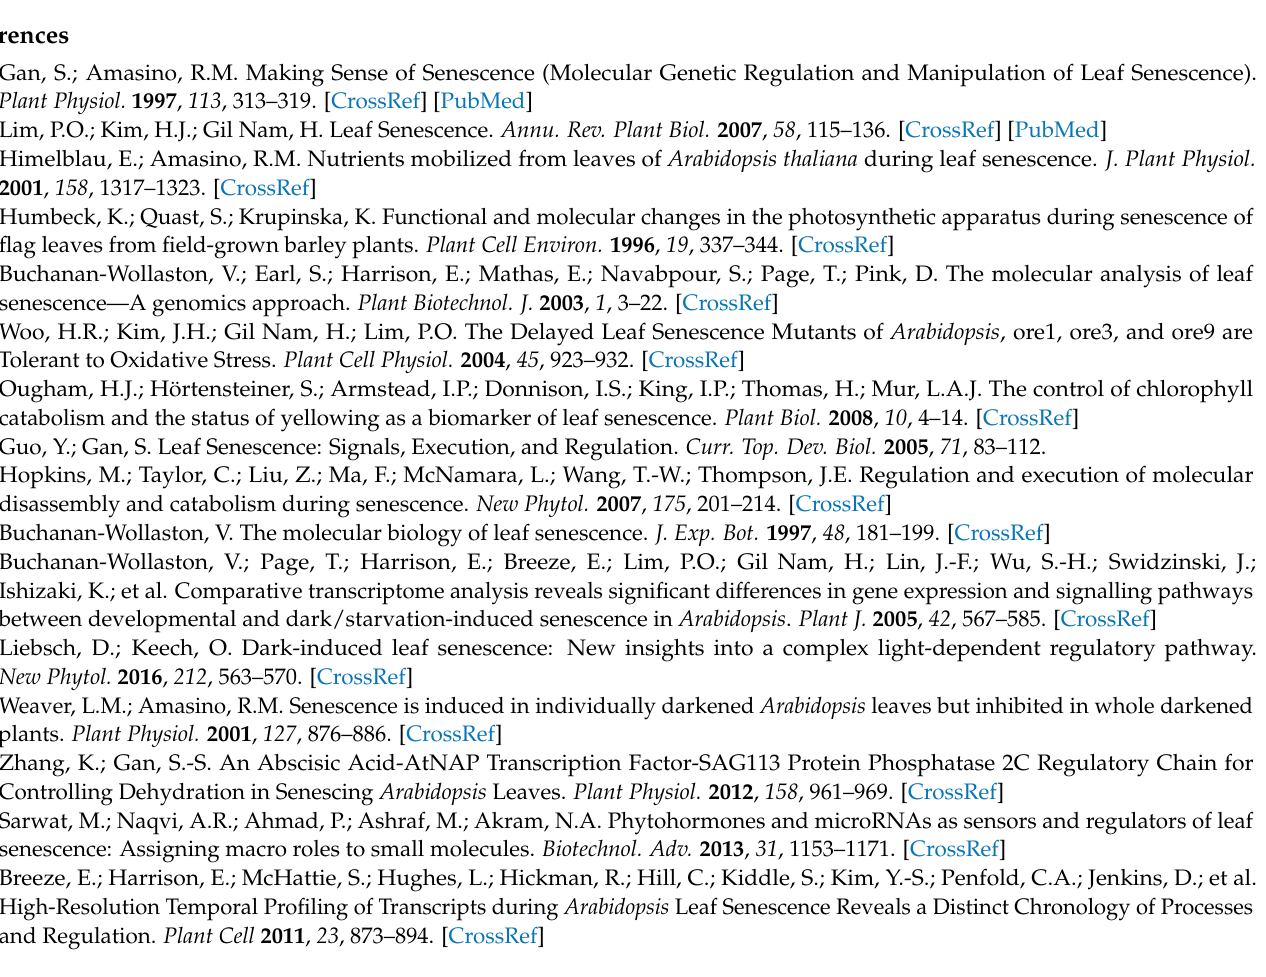
senescence. Figure S5. Further confirmation of the relative expression levels of genes encoding cell expansins and those involved in defense responses in senescent leaves of AtWAKL10 OE1 line. Table S1. List of primers used in Y1H assays, genotyping and generation of transgenic lines. Table S2. List of primers used in qRT-PCR transcript analysis. Table S3. List of genes quantified in atwakl10 mutant and AtWAKL10 OE2 line in senescent (S) and non-senescent (NS)